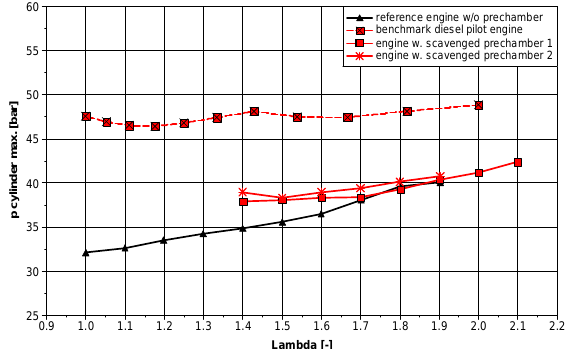
Fig. 9. Peak cylinder pressures for the operating point 1 (1400 rpm/50 Nm/ bmep 3.2